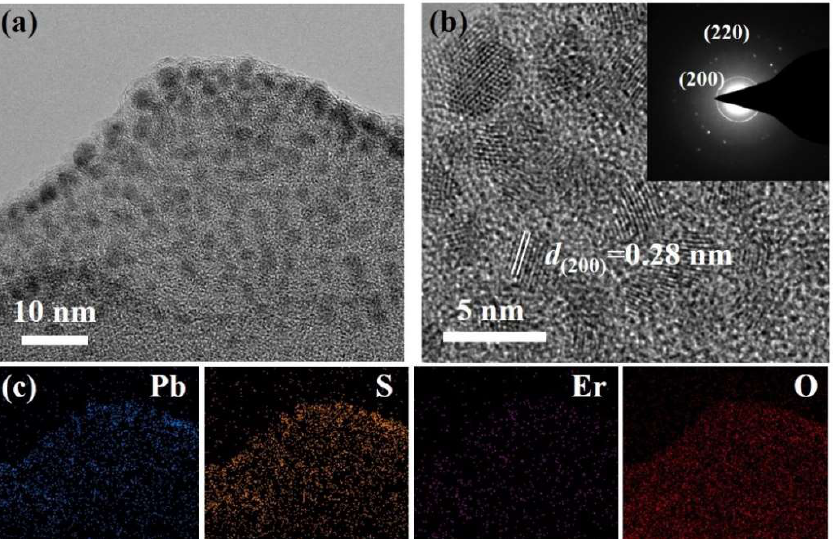
Figure 8. ( a ) TEM image of PEDF; ( b ) HRTEM image of PEDF, and the inset is the corresponding SAED; ( c ) elemental mapping of PEDF.